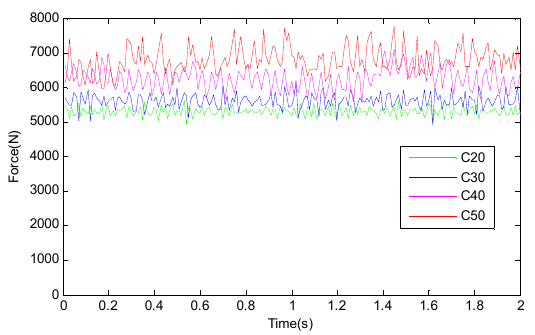
Figure 10. Torque diagram of bit drilling in the rock experiment. Figure 9. Drilling experiment of the drill bit. Figure 9. Drilling experiment of the drill bit. Figure 9. Drilling experiment of the drill bit.